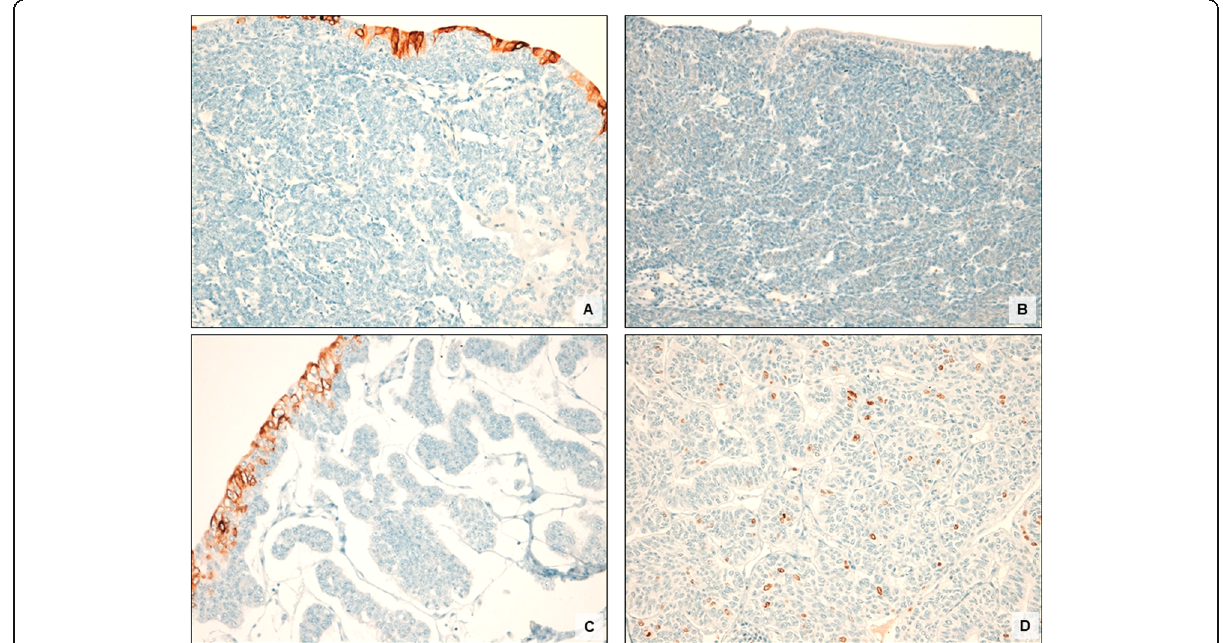
Fig. 2 Immunohistochemical results in two cases of IUP pf the upper urinary tract. Both cases were negative for CK20 immunostaining ( Case 1: a ; Case 2: c) and showed low Ki-67 labelling index (< 1%) ( Case 2: b ; Case 2: